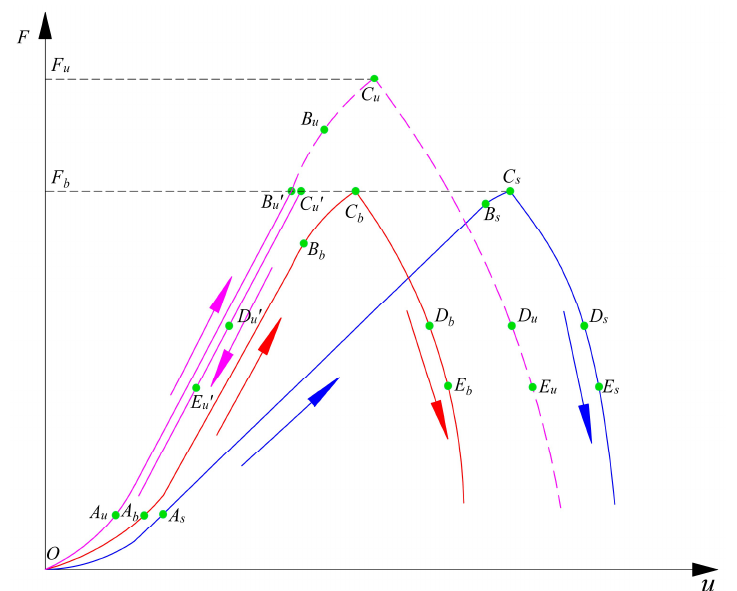
Figure 17. Relationship of load-displacement for serial coal pillar specimens (different strength).